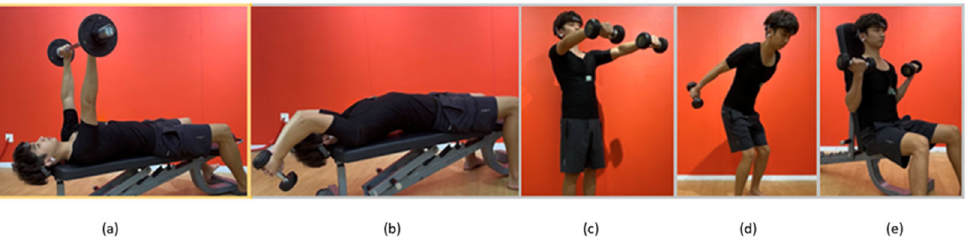
Figure 4. Exercise and its muscles: ( a ) Bench press: pectoralis major, lateral deltoids, triceps; ( b ) Pullover: pectoralis major (chest); ( c ) Front rise: lateral deltoids (shoulders); ( d ) Kick back: triceps brachii; ( e ) Bicep curls: biceps.